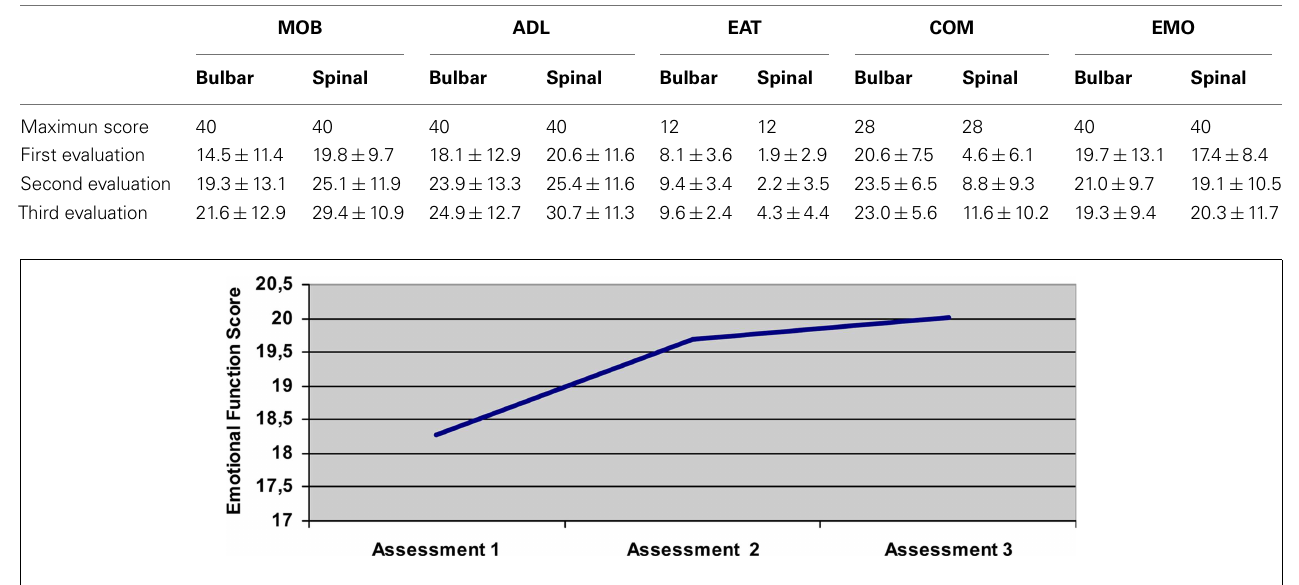
FIGURE 1 | Evolution of EMO along the three evaluations for the total sample.